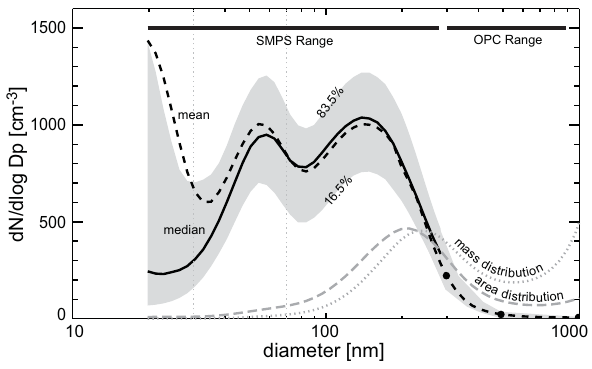
Figure 2: Mean (dashed, SMPS and OPC) and median (solid, SMPS only) aerosol size distribution from the SMPS (20-280 nm diameter) and OPC (>300 nm diameter) for the period 23 October-15 Nov 2008. The solid circles show the OPC size distribution for the three submicron size categories (0.3, 0.5 and 1 μ m) and the fit to these points is used to extend the mean size distribution to cover the entire submicron range. The gray shaded area shows the central 67% (16.5 and 83.5 percentiles) of the size distribution variability. Also shown are the mass and area distributions (arbitrary ordinate scaling) for the mean size distribution.